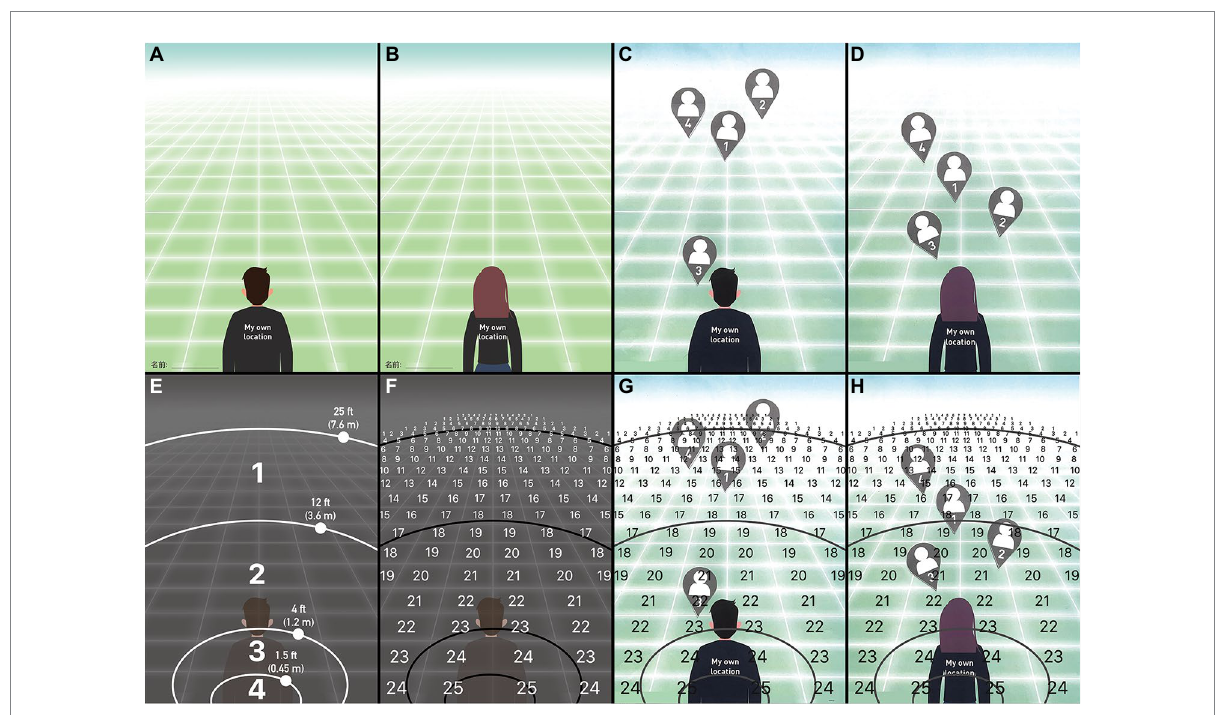
FIGURE 3 (A) Visual stimulus material for those who identified as males; (B) Visual stimulus material for those who identified as females; (C) Example of a worksheet completed with four tasks of the humanoid card, pasted by a participant who identified as male; (D) Example of a worksheet completed with four tasks of the humanoid card, pasted by a participant who identified as female; (E) Classification of personal space represented in visually stimulating materials; (F) Specific scores (from 1 to 25 scores) for each square represented in the visual stimulus material; (G) Example of